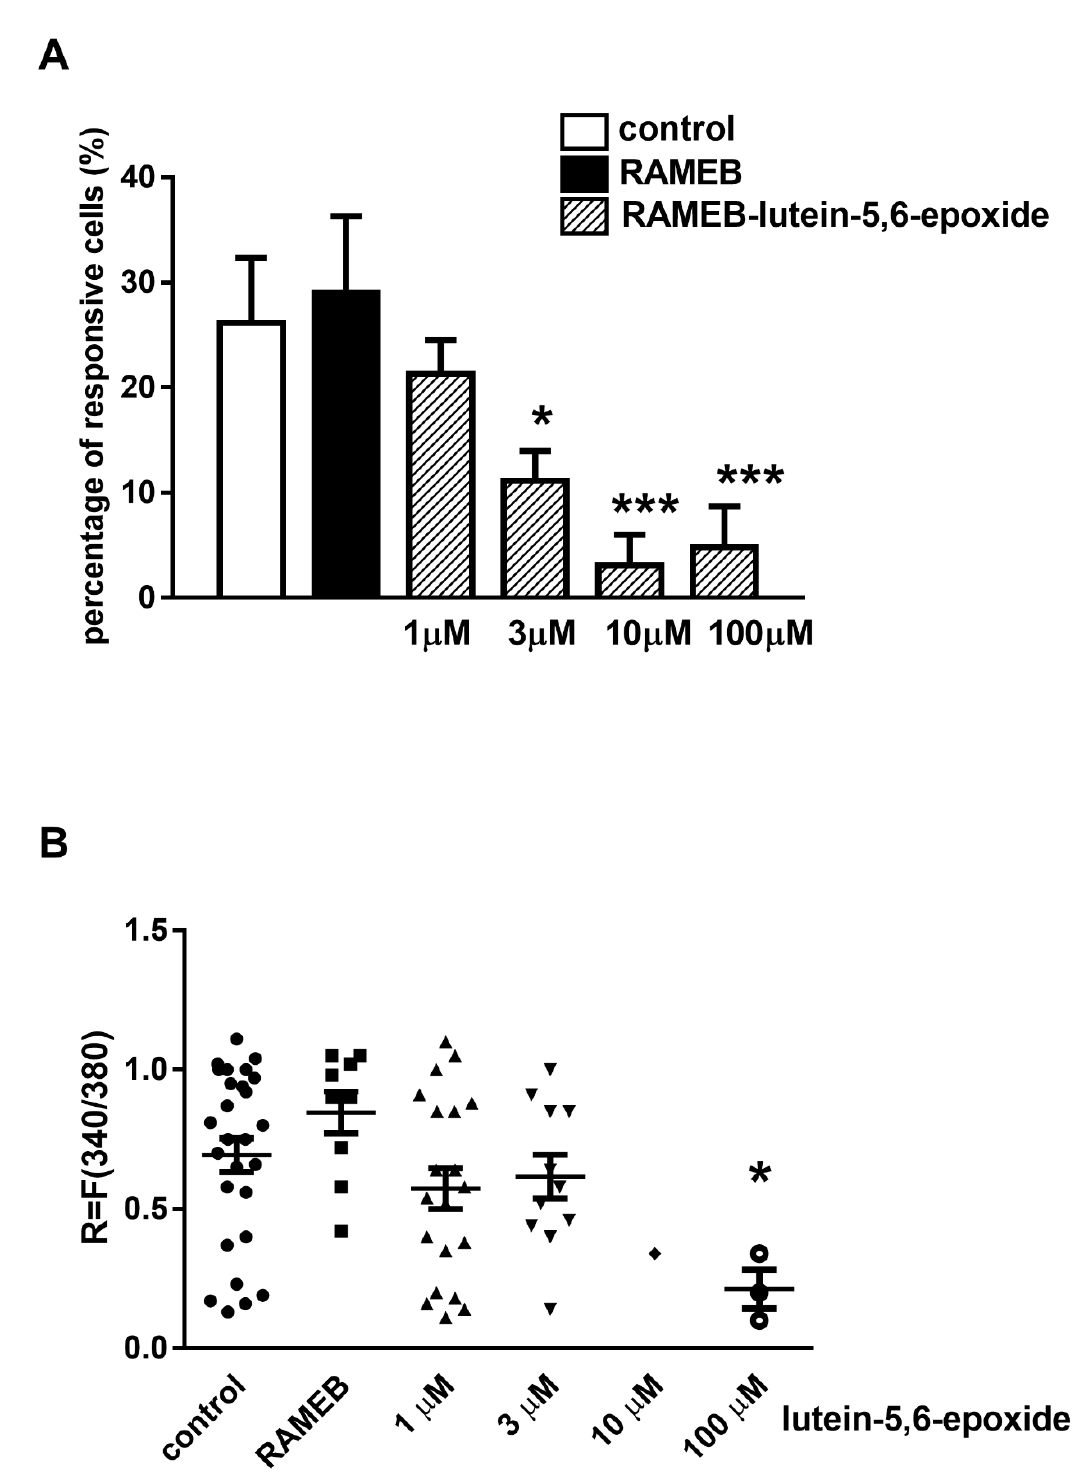
Figure 4. Effect of randomly methylated- β -cyclodextrin-(RAMEB)-lutein 5,6-epoxide on TRP Ankyrin 1 (TRPA1) activation-induced Ca 2+ -influx in cultured trigeminal ganglion neurons. ( A ) Columns show the percentage of neurons responding to the TRPA1 activating agent mustard oil (MO, 200 μM) in untreated control, RAMEB-solvent-treated control and 1, 3, 10 and 100 μM RAMEB-lutein 5,6-epoxide-treated cell cultures. N = 31–107 cells per group. *** p < 0.001, (vs. RAMEB alone, One-way ANOVA, Bonferroni’s post hoc test). ( B) Change in the fluorescence ratio (R = F340/F380) is presented after 1–100 µM RAMEB-lutein 5,6-epoxide treatment. Dot plot represents mean + SEM * p < 0.05, (Kruskall-Wallis test with Dunn’s post-test, RAMEB-lutein 5,6-epoxide vs. RAMEB control). N = 31–107 cells per group.